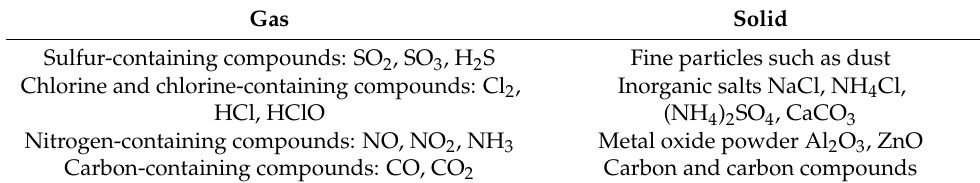
Table 2. Main components of air pollution. Gas Solid Sulfur-containing compounds: SO 2 , SO 3 , H 2 S Fine particles such as dust Chlorine and chlorine-containing compounds: Cl 2 , Inorganic salts NaCl, NH 4 Cl, HCl, HClO Metal oxide powder Al 2 O 3 , ZnO Carbon-containing compounds: CO, CO 2 Carbon and carbon